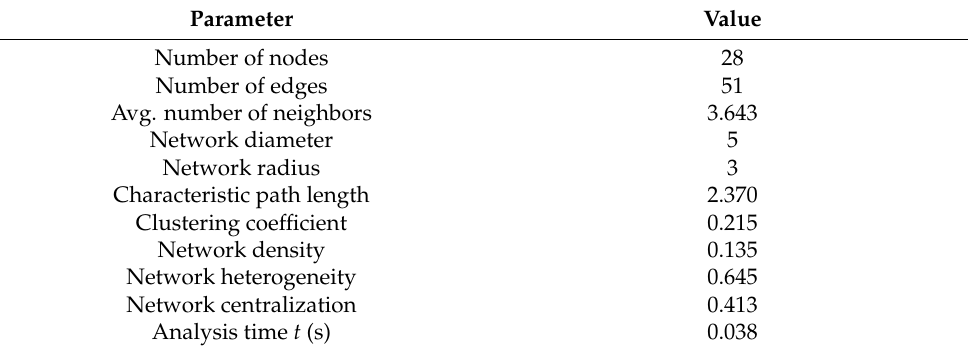
Table 6. Summary statistics concerning the parameters of the complex network of Figure 3b.